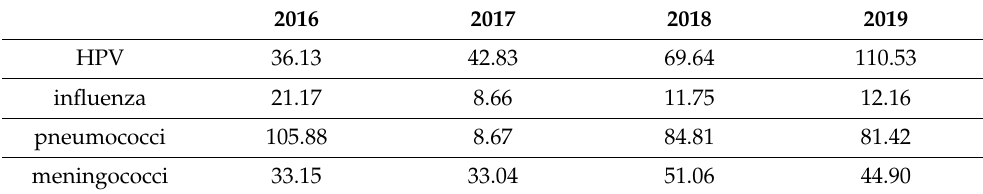
Table 5. Unit cost (in USD) of vaccines between 2016 and